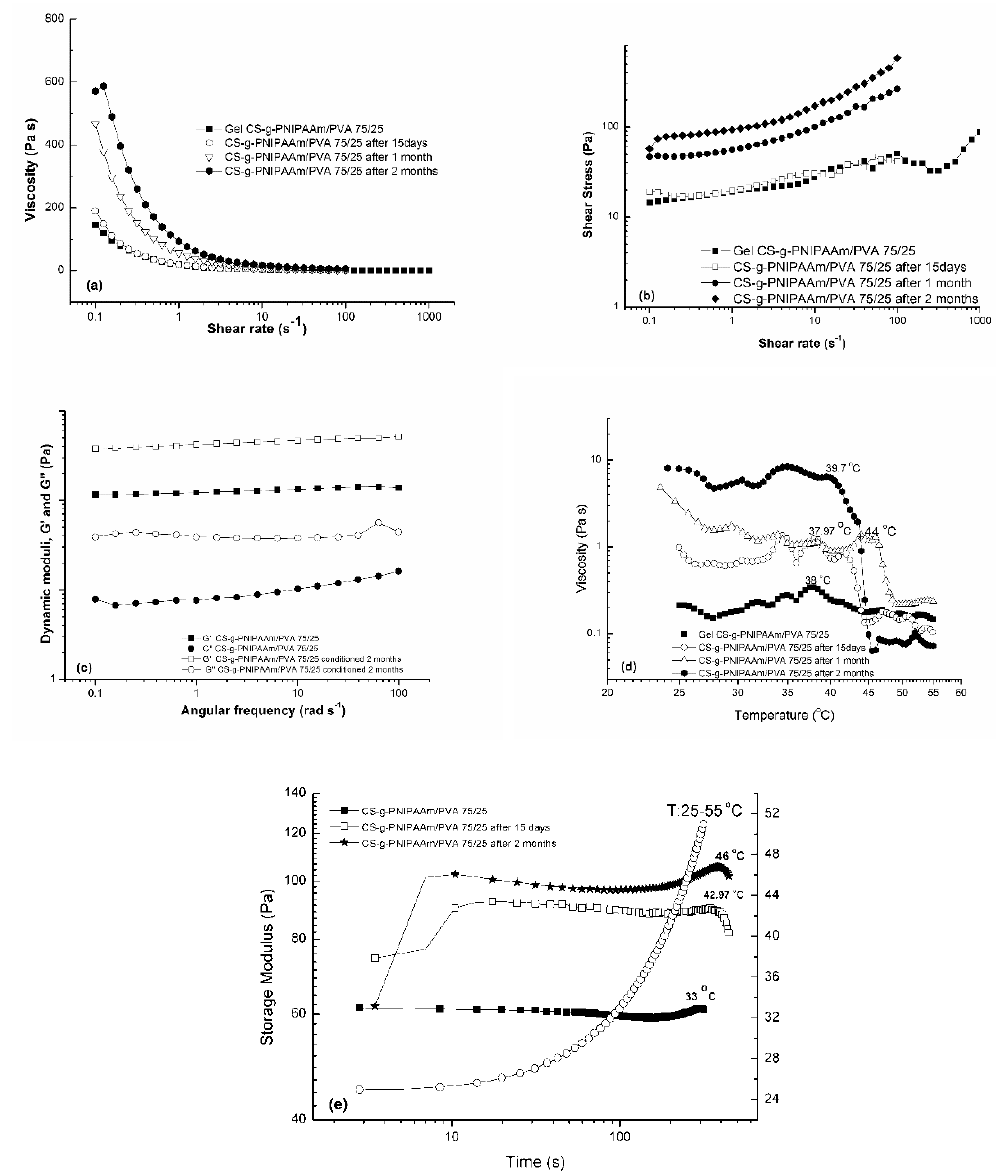
Figure 8. Rheological curves of CS- g -PNIPAAm / PVA 75 / 25. ( a ) Viscosity dependency on the share rate; ( b ) share stress–share rate curves; ( c ) variation of dynamic moduli, storage G’, and loss G” moduli with the angular frequency; ( d ) temperature sweep curves; and ( e ) time–temperature sweep tests.